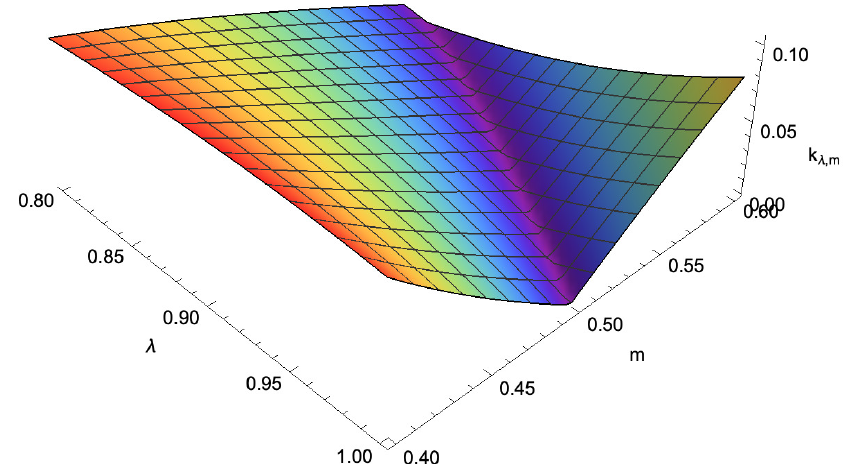
Figure 10. A neighborhood of the Puig-Adam’s choice of parameters where la Cierva’s surface is